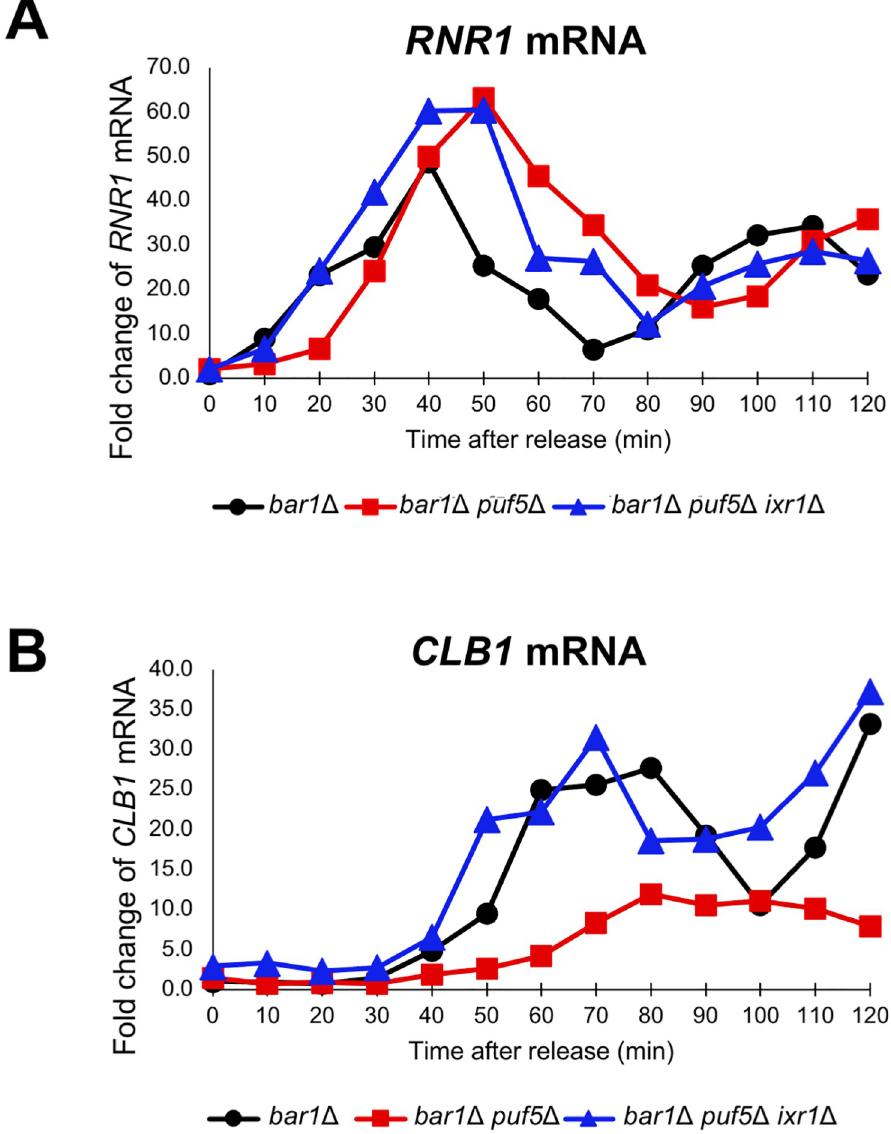
Fig 10. IXR1 deletion restored the decreased expression of CLB1 caused by PUF5 deletion. (A, B) The cell cycle- dependent mRNA levels of CLB1 (B) in the cell cycle synchronized bar1 Δ cell (black circle), bar1 Δ puf5 Δ mutant (red square), and bar1 Δ puf5 Δ ixr1 Δ mutant (blue triangle). The cell cycle was arrested in the G1 phase by α -factor, and, after release, cells were collected from 0 min (just before releasing) to 120 min. The levels of RNR1 mRNA (A), an S phase marker, and CLB1 mRNA (B) were quantified by qRT-PCR analysis, and the relative mRNA levels were calculated using the SCR1 reference gene. The vertical axis shows the fold change of mRNA relative to the mRNA level in the bar1 Δ 0 min sample, and the horizontal axis shows the time after